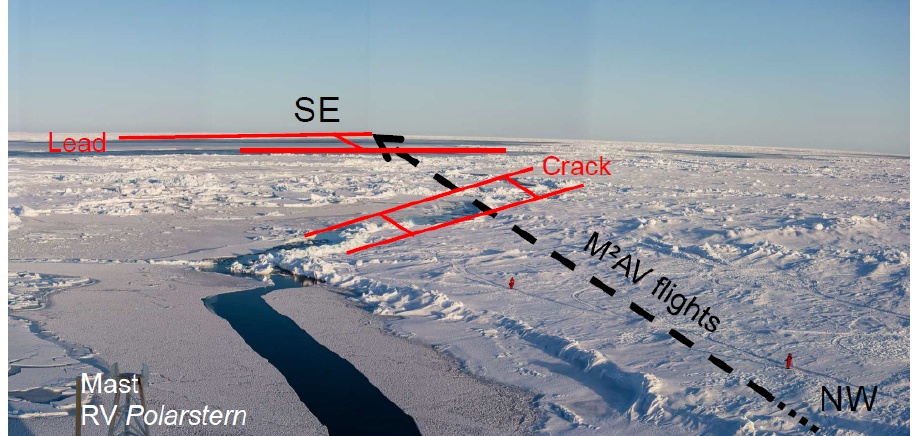
Figure 13. Ice conditions during the ice station of Polarstern on 2 August 2013. The flight path of the M 2 AV is indicated as black dashed line. The locations of open water that were investigated during perpendicular flights are shown in red. Photo: Stefan Hendricks,